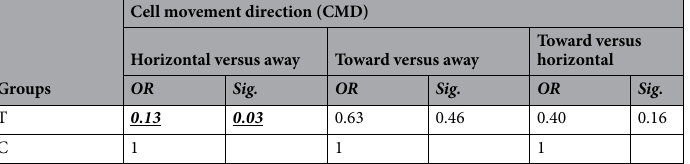
Toward versus horizontal